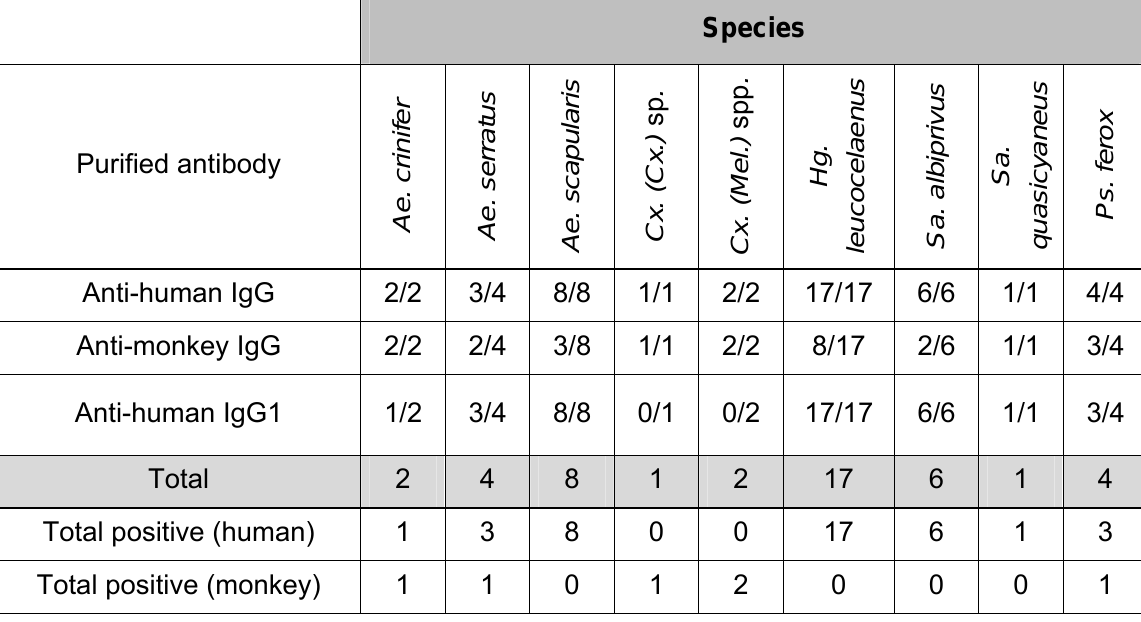
Table 1. Distribution by purified antibody (IgG) of Culicidae samples from Santo Antônio das Missões, RS, collected between September 2005 and April 2007 Species